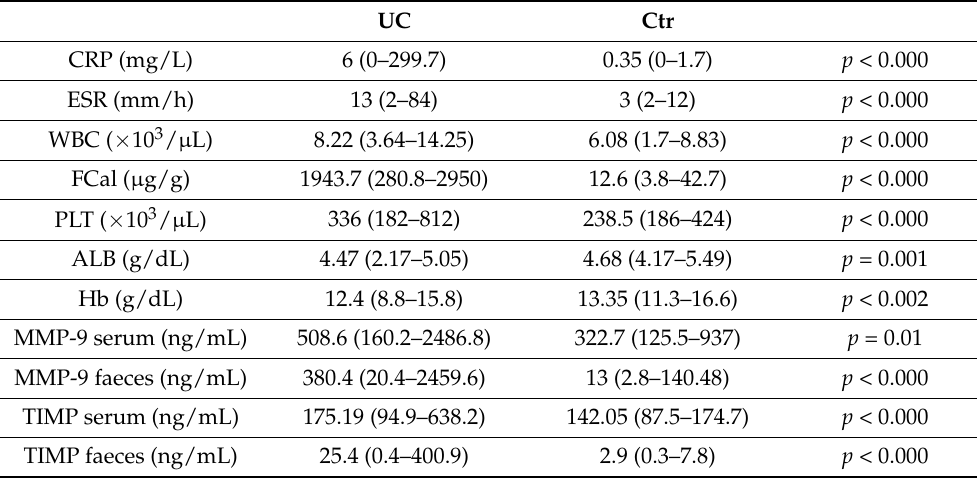
Table 2. Biochemical markers of inflammation and measurement of serum and faecal MMP-9 and TIMP-1 in children with UC and Ctr.